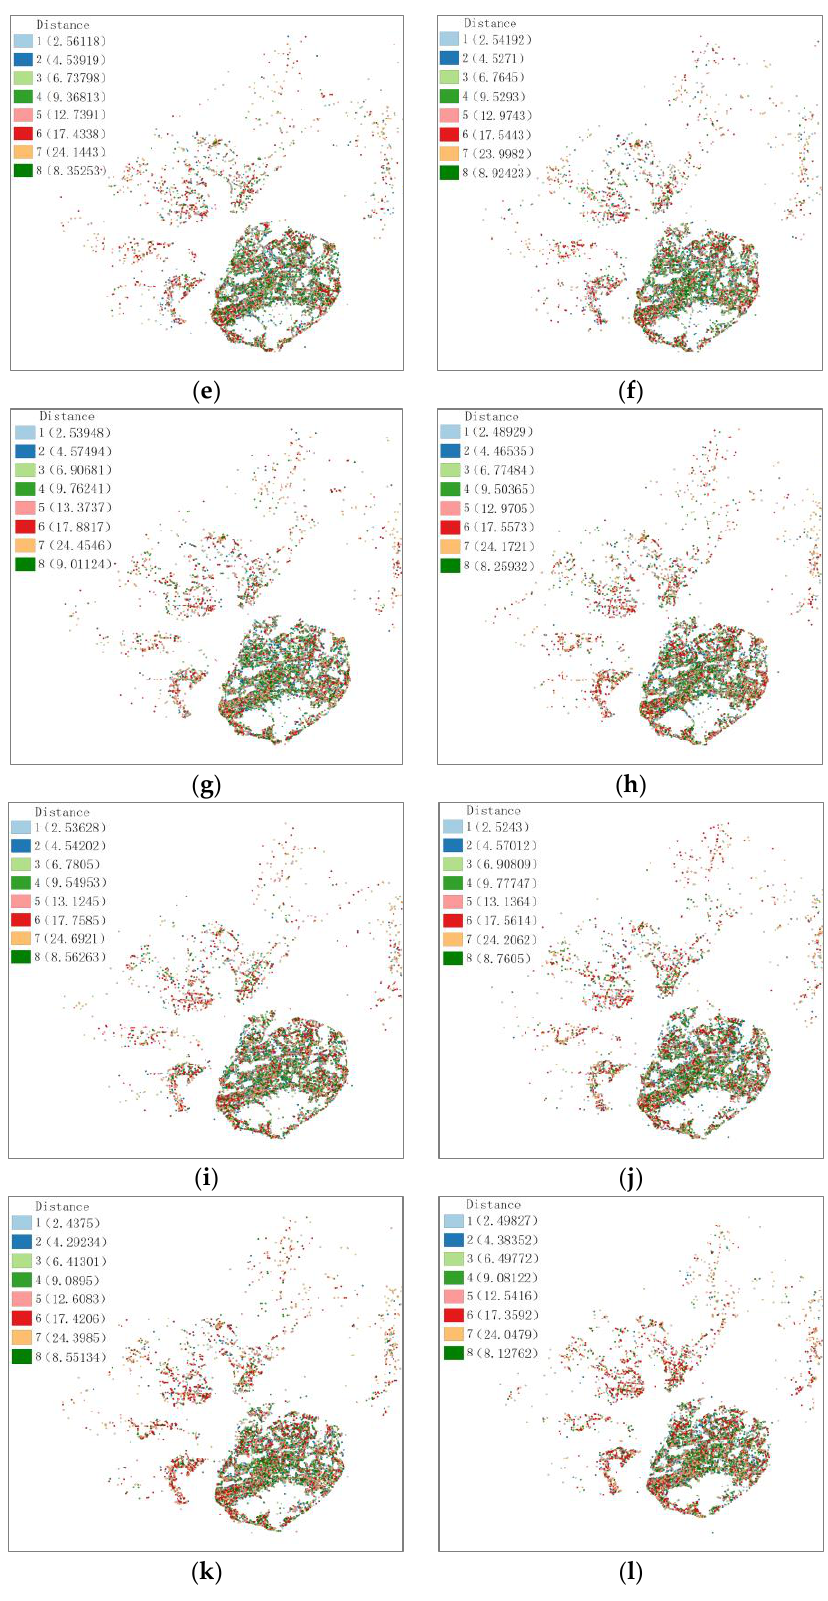
Figure 5. Cluster analysis of the travel distance and boarding location for each period. ( a – l ) rerep- resent 12 periods spectively in a day.